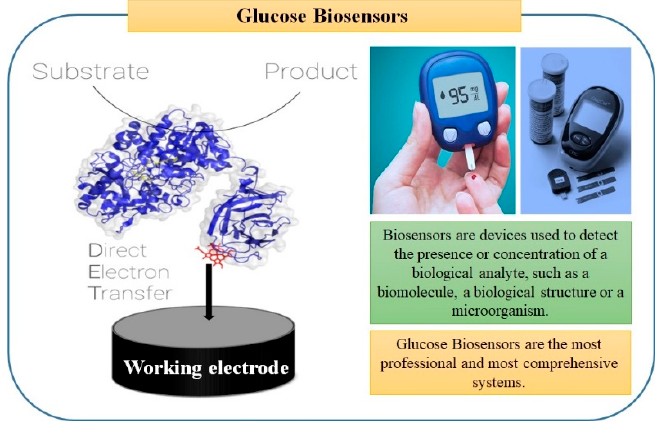
Figure 1. Glucose biosensors, the most common example of electrochemical biosensors, consists of a digital pocket (portable reader) and a sensor chip (a three-electrode setup represents a reference electrode, a counter, and a working electrode). The selective determination of glucose concentration in samples is catalyzed by the enzymatic function of glucose oxidase loaded onto the surface of the working surface [10,11].